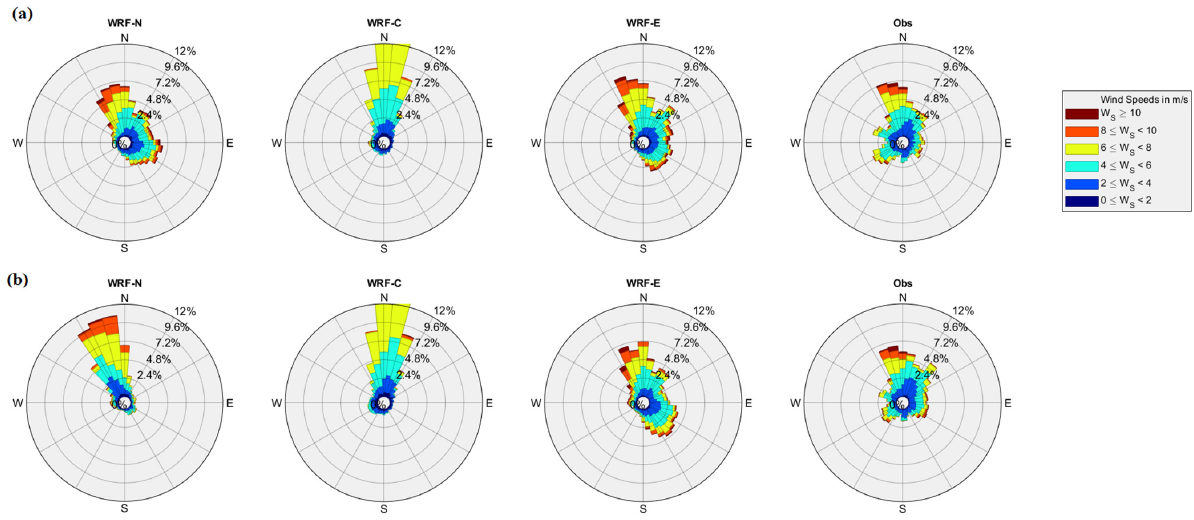
Figure 6. Wind rose diagram from the models and observations for the years ( a ) 2015 and ( b ) 2016 in Hong Kong.